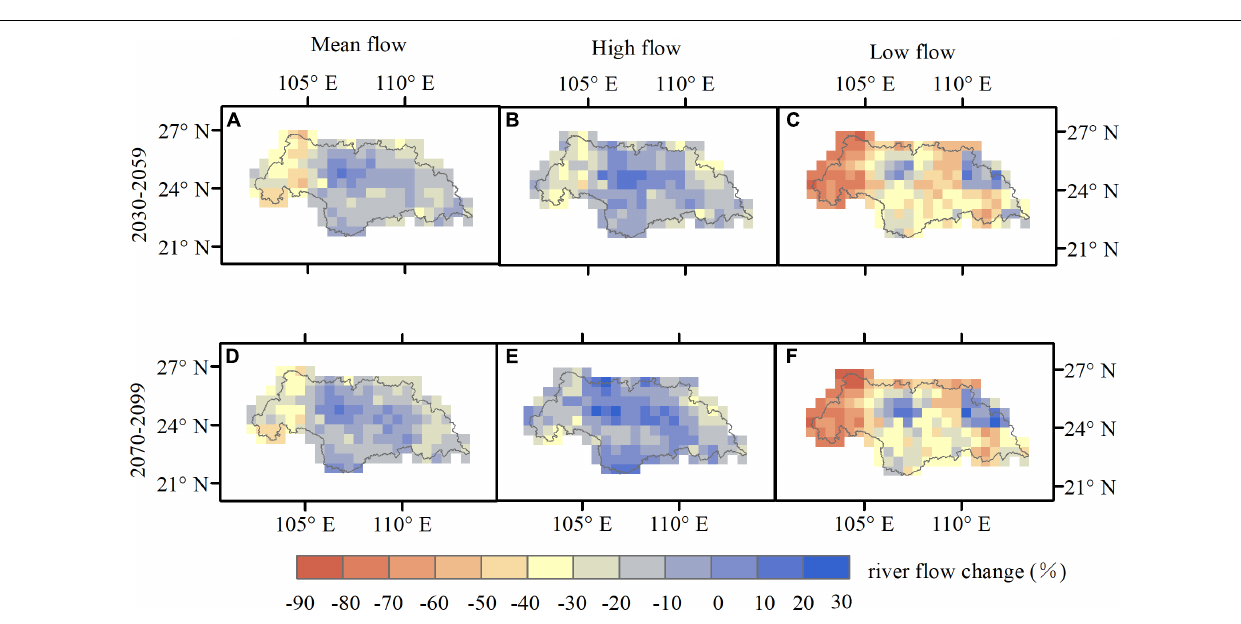
FIGURE 3 | Changes in river flows between the future period 2030–2059 and the historical period 1971–2000: (A) mean flow, (B) high flow (Q95), and (C) low flow (Q10), and changes in river flows between the future period 2070–2099 and the historical period 1971–2000: (D) mean flow, (E) high flow (Q95), and (F) low flow (Q10) over the Xi River